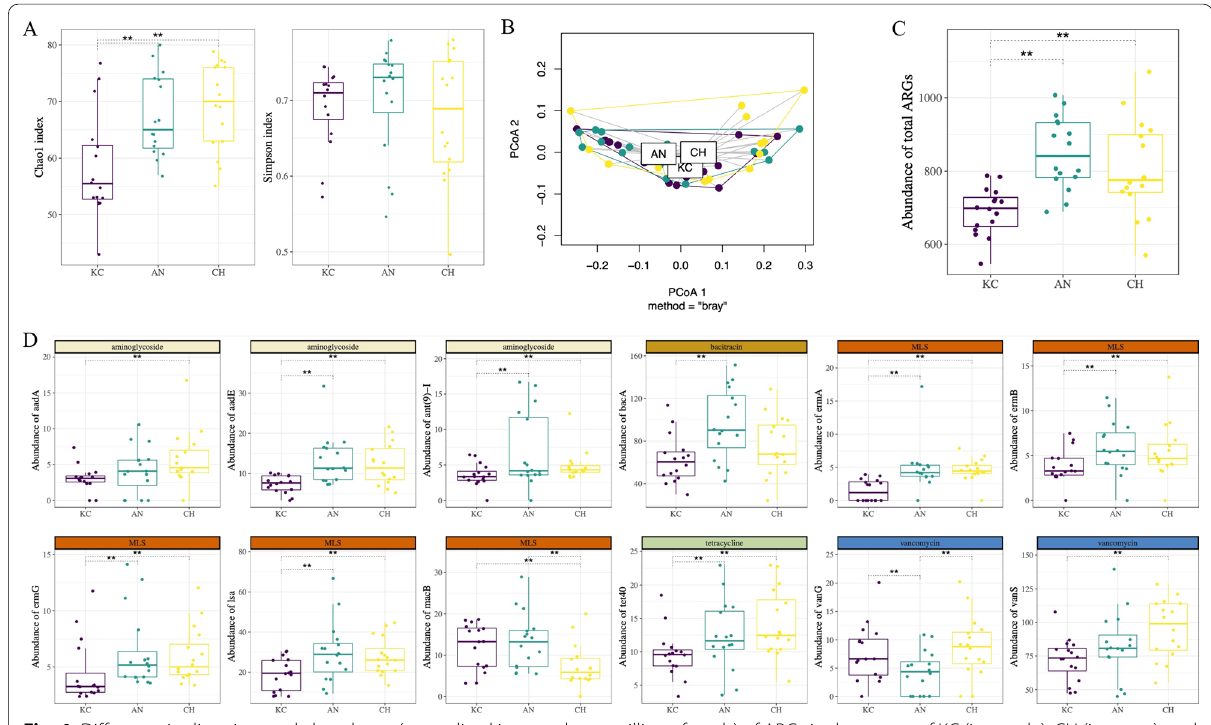
Fig. 4 Difference in diversity annd abundance (normalized into reads per million of reads) of ARGs in the rumen of KC (in purple), CH (in green), and AN (in yellow) beef steers. a Difference in Chao1 index and Simpson’s index among breeds. b PCoA based on Bray–Curtis distance. c Difference in the abundance of total ARGs among breeds. d Difference in the abundance of 12 ARGs belonging to aminoglycoside, bacitracin, MLS, tetracycline, and vancomycin classes among breeds. ARG, antimicrobial resistant gene; KC, Kinsella composite hybrid; AN, Angus; CH, Charolais; MLS, macroli de-lincosamide-streptogramin; MDR, multidrug. PCoA, principal coordinate analysis. ** P < 0.05 by Kruskal–Wallis test followed by multiple pairwise comparisons using Dunn’s test with Benjamini–Hochberg method for false discovery rate